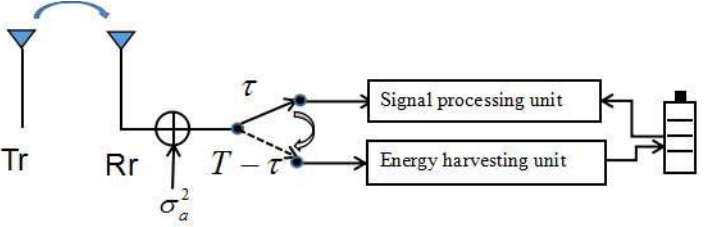
Figure 3. A practical transceiver design with time switching